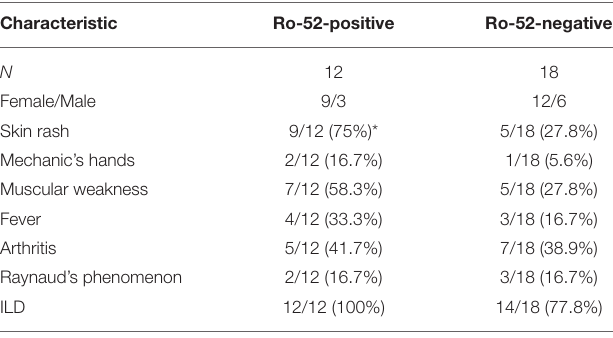
TABLE 2 | Differences between the anti-PM/Scl patients with and without Ro-52.